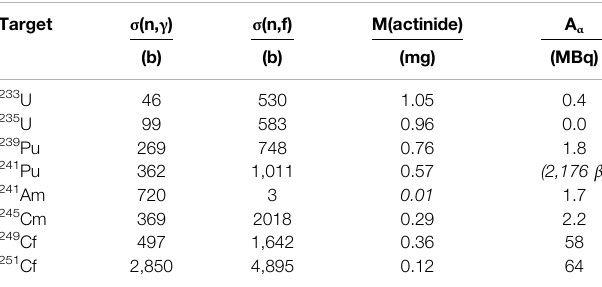
TABLE 4 | Properties of different actinide fi ssion targets (cross-sections and half- lives were taken from [49]). The target mass required to reach a fi ssion rate